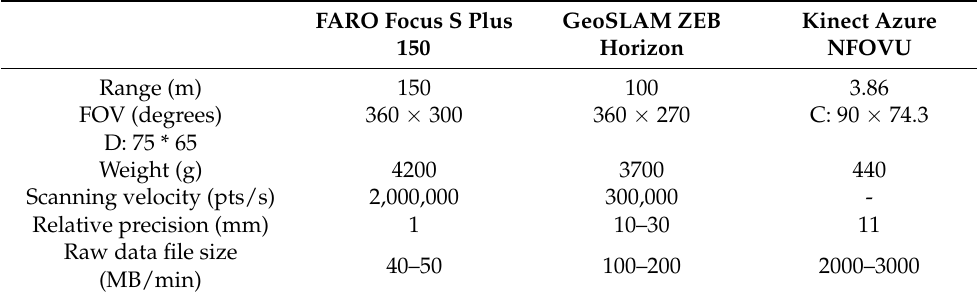
Table 1. Comparison of the technical specifications of three devices (Microsoft Kinect Azure 2019, FARO 2019, GeoSLAM